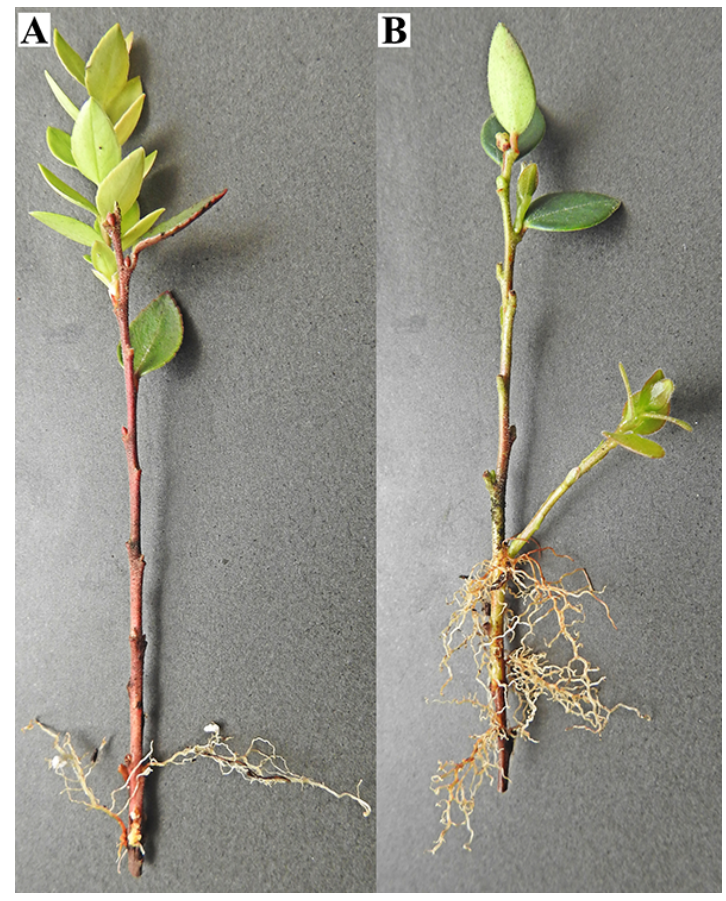
Figure 2 Representative cuttings of the wild blueberry accessions with a superior rooting